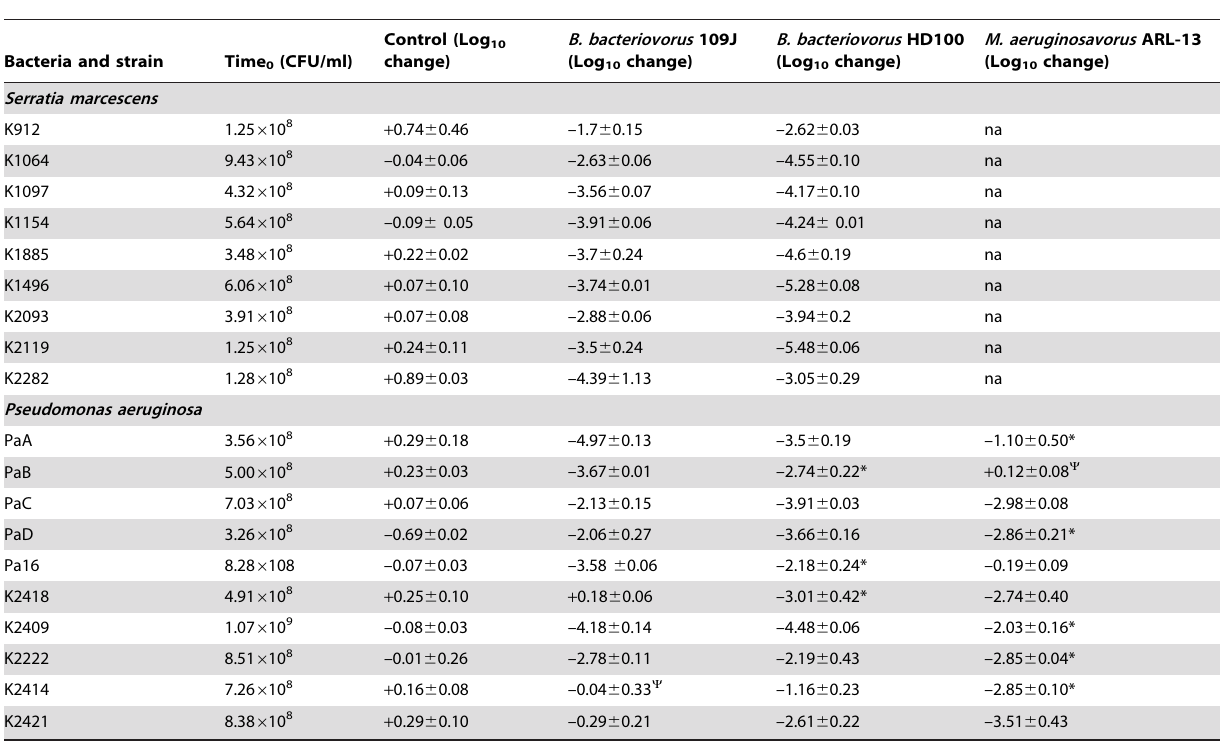
Table 1. Predation of S. marcescens and P. aeruginosa ocular isolates by predatory bacteria.